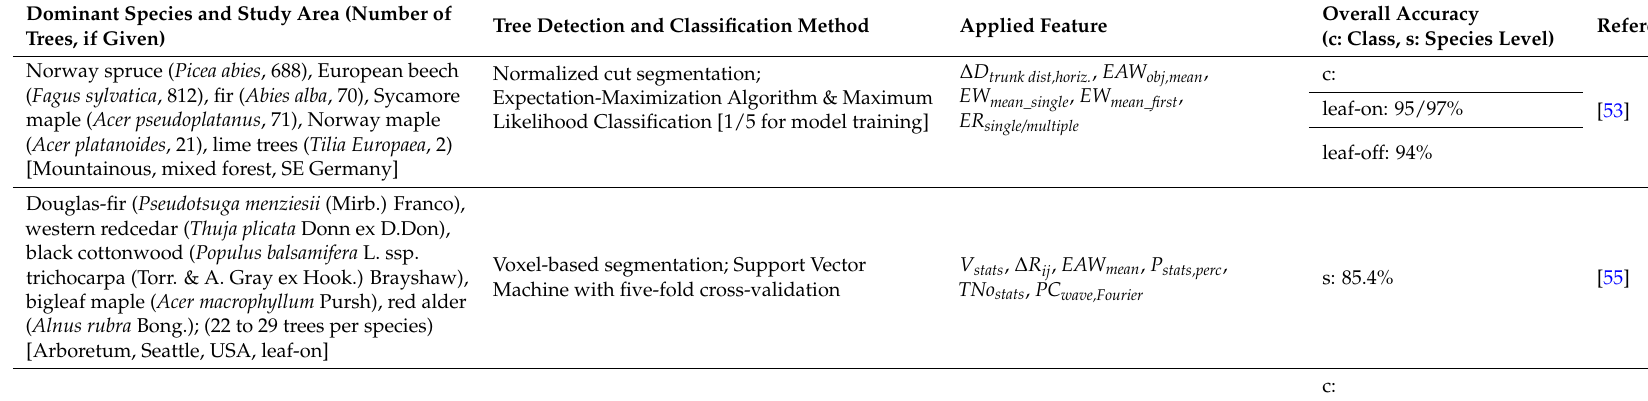
Table A4. Overview of applied feature sets for species classification and the overall accuracies achieved by different studies. Dominant Species and Study Area (Number of Tree Detection and Classification Method Applied Feature Trees, if Given)